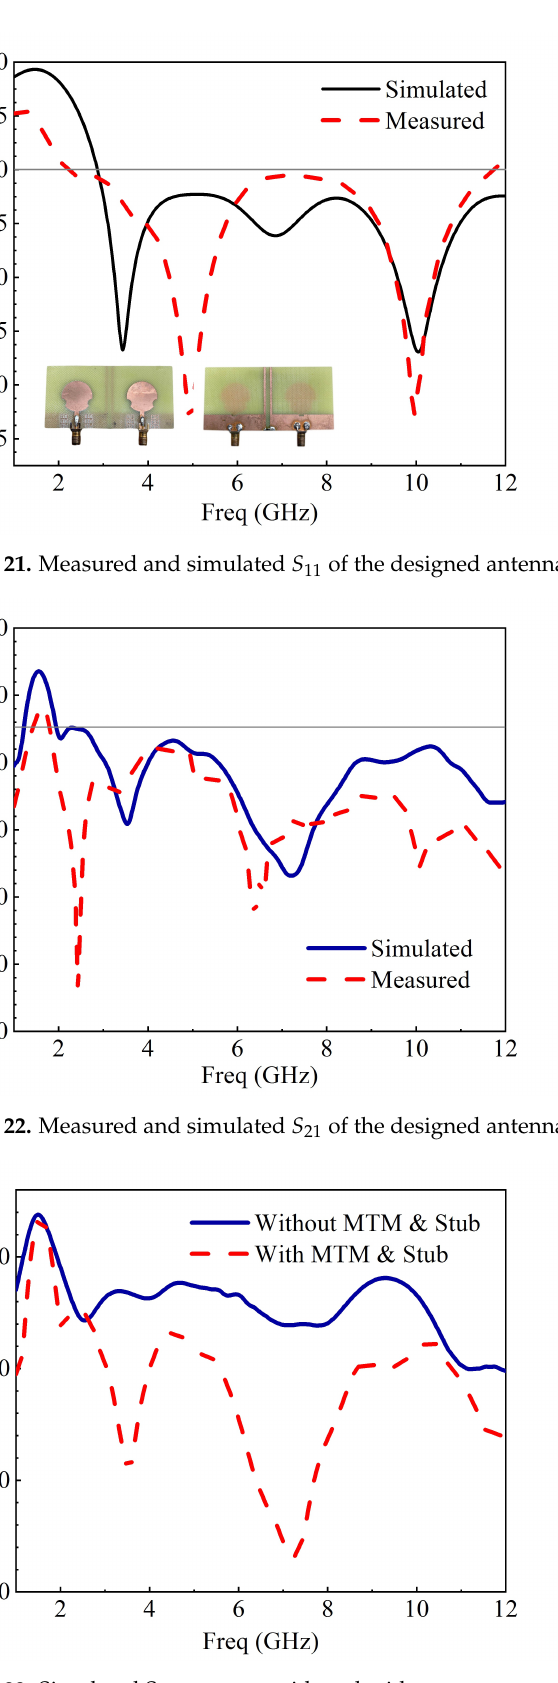
Figure 23. Simulated S-parameter with and without